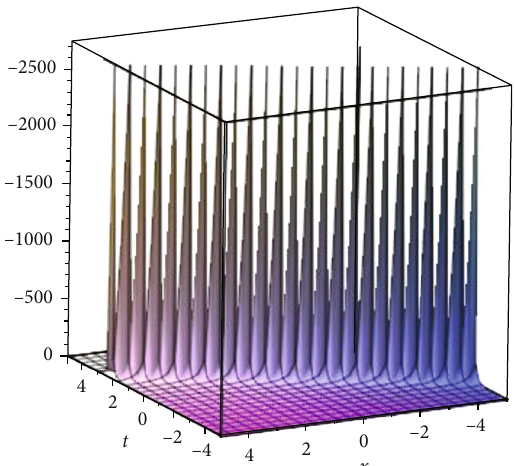
Figure 2: Perspective view of 3D graph of W values ω = 2 , z 0 = − 0 : 5 , μ = 1 , k = 1 , and f = 1 represents the exact solution.